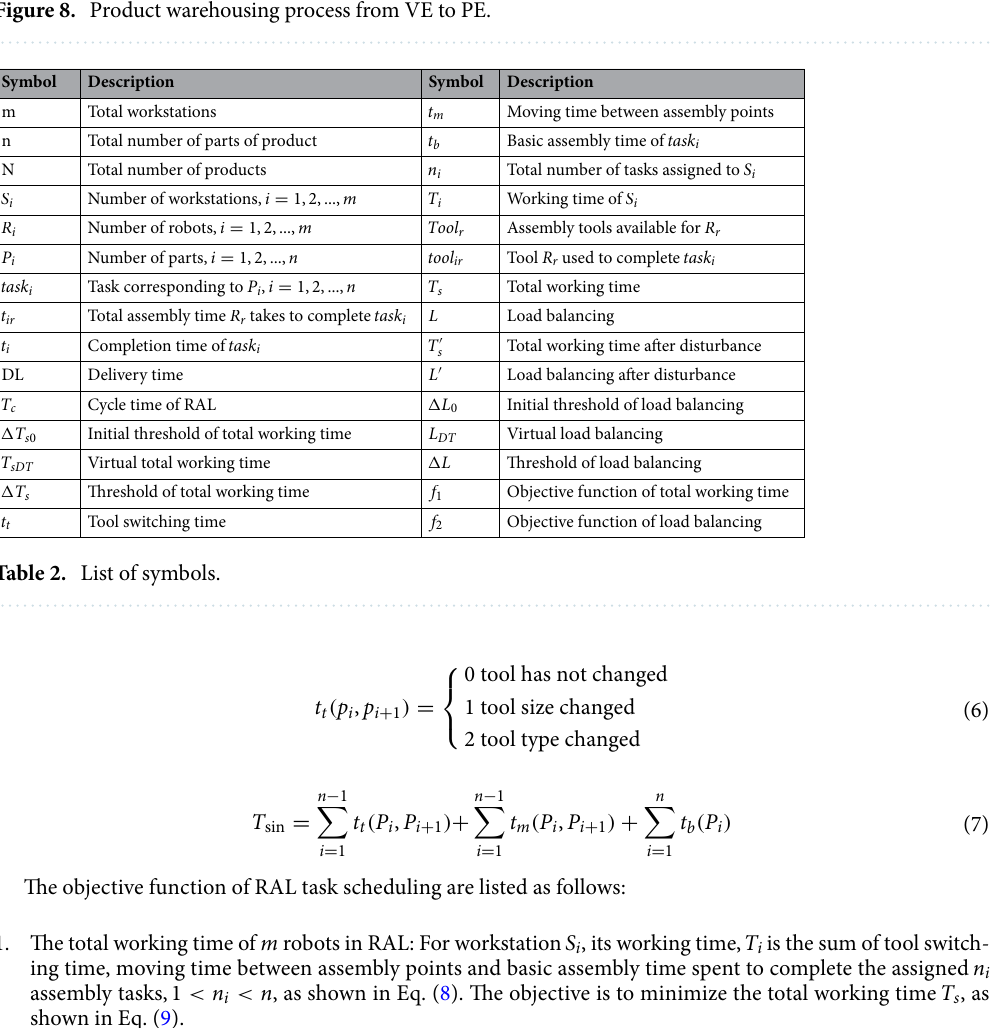
Figure 8. Product warehousing process from VE to PE.